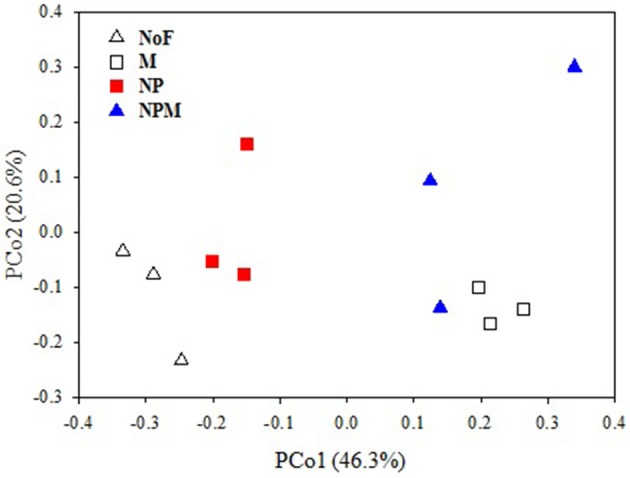
PCoA score plot of no fertilizer and fertilizer application soils in long-term trials based on weighted Fast UniFrac metric. Values on PCoA axes indicate the percentages of total variation explained by each axis. NoF, no fertilizer; M, organic manure; NP, nitrogen plus phosphorus; NPM, NP plus M.